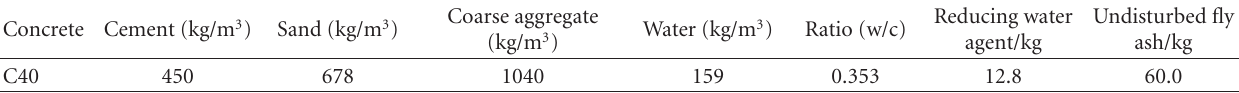
Table 1: Mix proportion of the concrete mixtures.